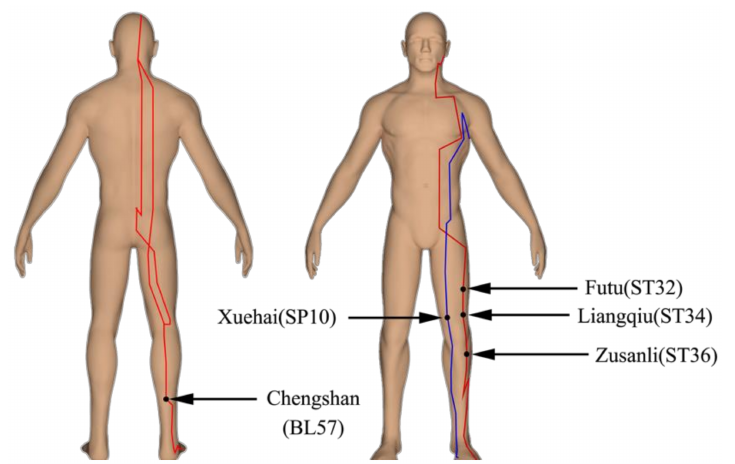
Figure 2. Schematic diagram of 5 acupuncture points located on the front and back sides of the lower extremity for true acupuncture and sham